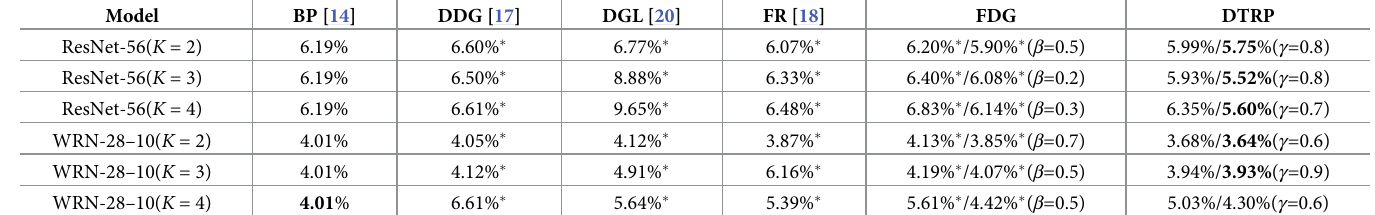
Table 6. Top-1 errors (%) for models with different K on CIFAR10.